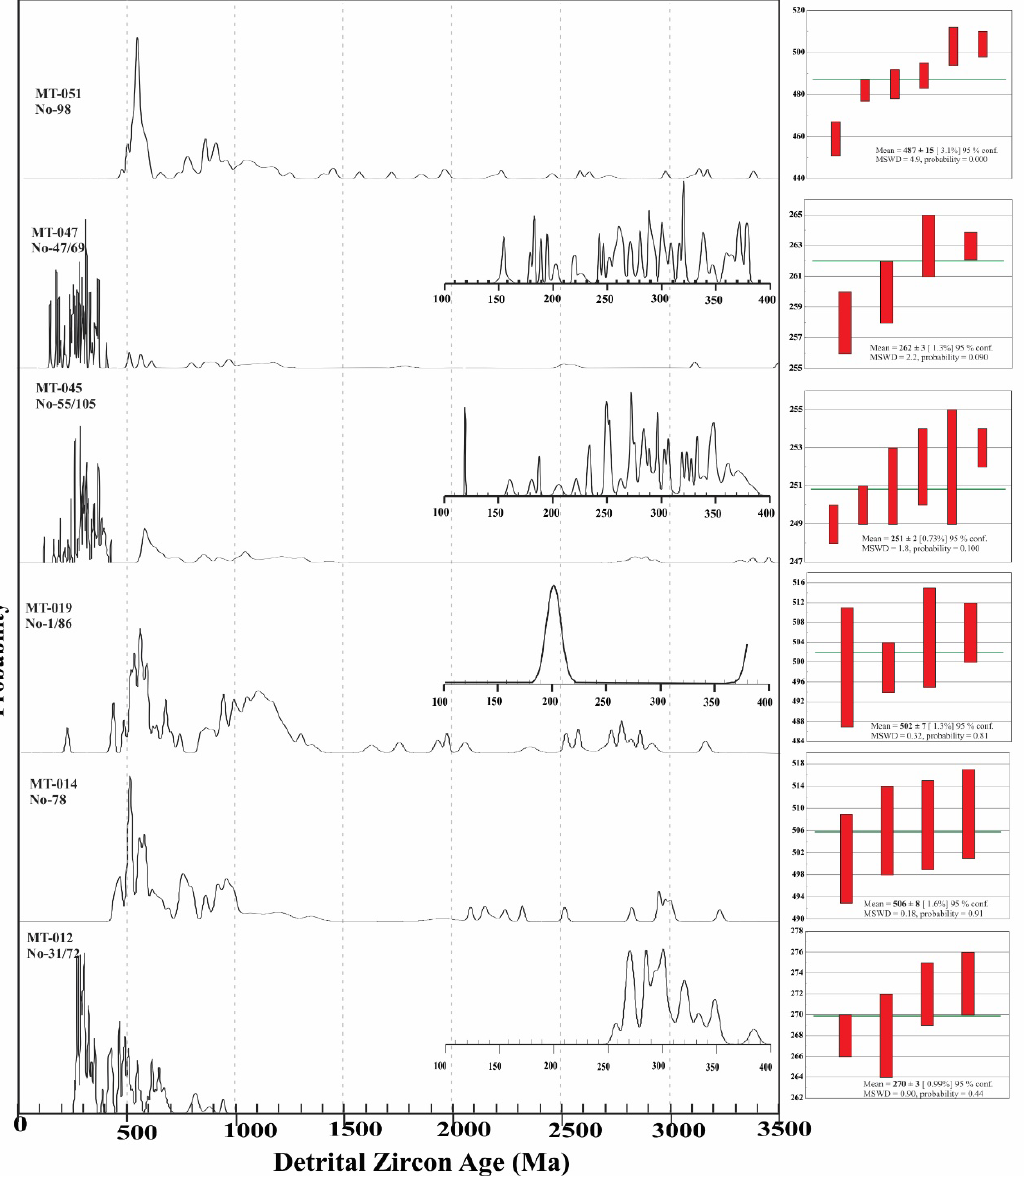
Figure 6. Normalized probability plot of quartzite detrital zircon U-Pb ages from this study, collected from the middle section of the Katha-Gangaw range. Samples include MT-012, MT-014, MT-019, MT-045, MT-047, and MT-051. No = number of grain analyses in which the denominator indicates the total numbers and the numerator indicates the number of grains younger than 400 Ma. The right figure of each sample indicates the maximum depositional age.